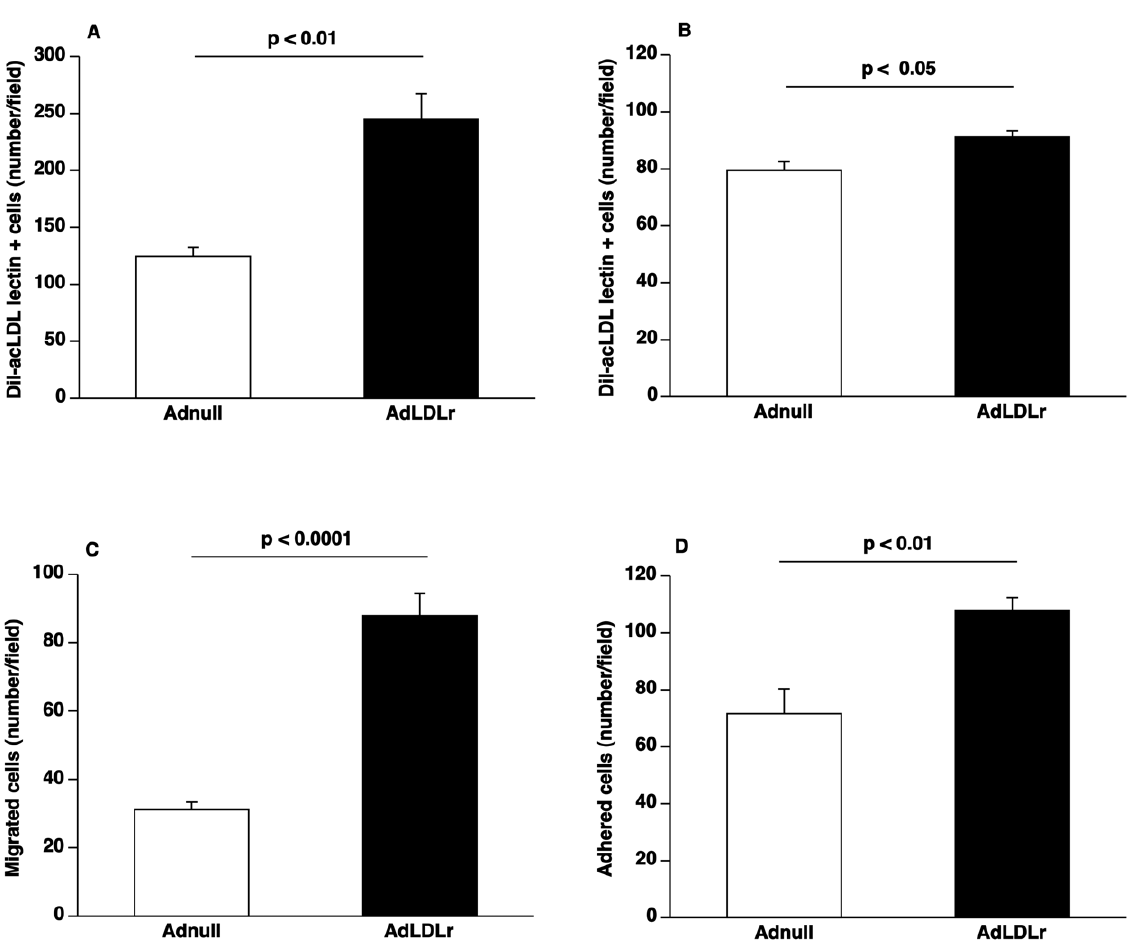
Figure 1. Lipid lowering gene transfer increases EPC number and enhances EPC function. ( A ) Bar graph showing the number of Dil-acLDL FITC-isolectin double positive cells after 7 days of ex vivo culture of spleen mononuclear cells isolated at day 14 after Adnull transfer or AdLDLr transfer in C57BL/6 LDLr 2 / 2 mice (n=5 for each group). ( B ) Bar graph illustrating the number of Dil-acLDL FITC-isolectin double positive cells after 7 days of ex vivo culture of bone marrow mononuclear cells isolated at day 14 after Adnull transfer or AdLDLr transfer in C57BL/6 LDLr 2 / 2 mice (n=6 for each group). ( C ) Bar graph showing the number of migrated EPCs in modified Boyden chambers. After 7 days of culture, spleen EPCs isolated at day 14 after transfer from Adnull mice or AdLDLr treated C57BL/6 LDLr 2 / 2 mice were seeded in the upper chamber. The number of migrated cells per microscopy field was quantified after 5 hours (n=12 for each group). ( D ) Bar graph illustrating the number of EPCs adhered to fibronectin-coated plates. After 7 days of culture, spleen EPCs isolated at day 14 after transfer from Adnull injected mice (n=6) or AdLDLr treated mice (n=6) were allowed to adhere onto fibronectin-coated plates for 30 minutes. Following vigorously washing with PBS, the number of adherent cells was counted under the microscope. Data are expressed as means 6